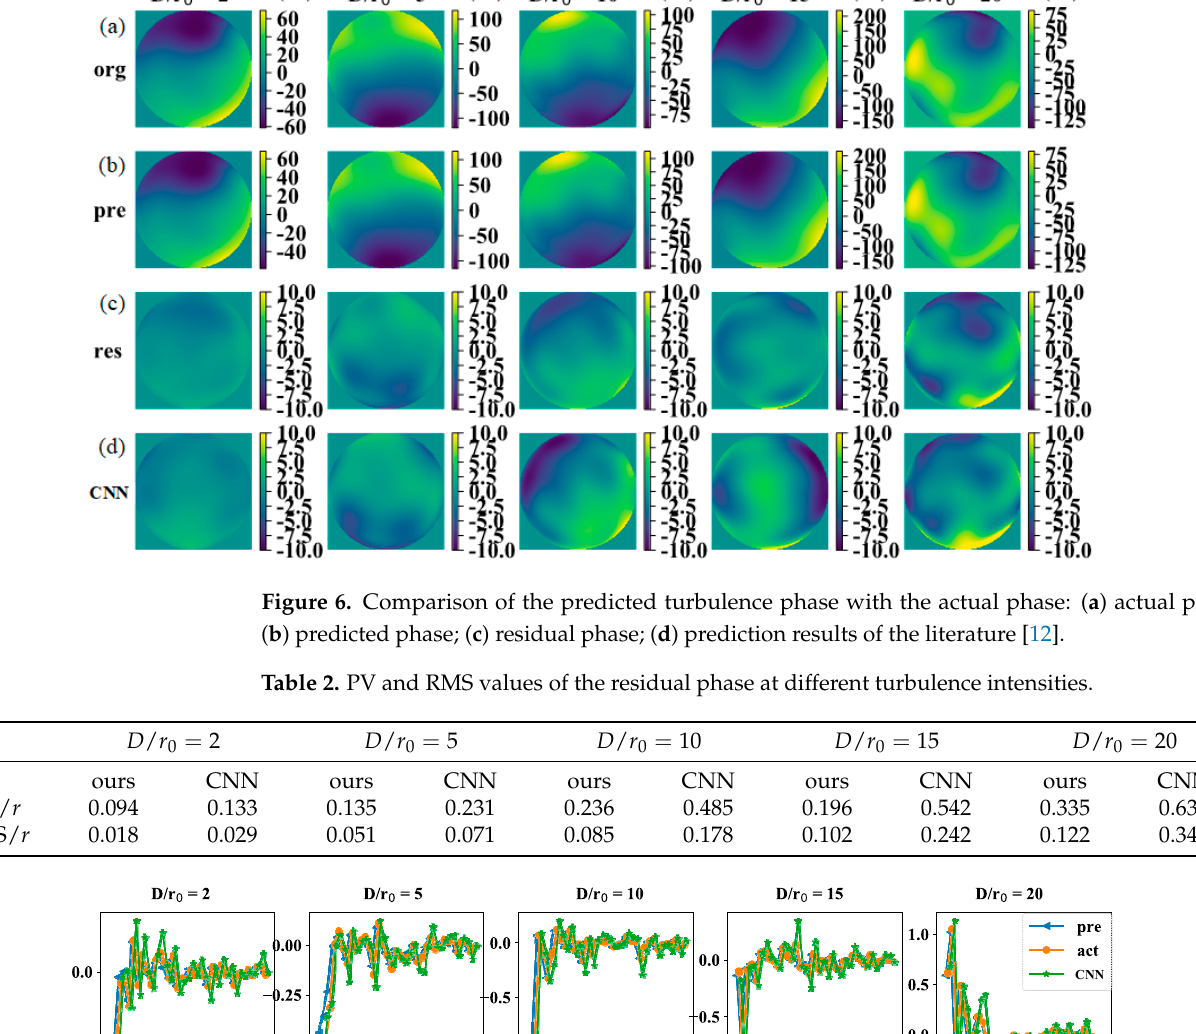
Figure 7. Predicted Zernike coefficient versus actual. Table 2. PV and RMS values of the residual phase at different turbulence intensities.